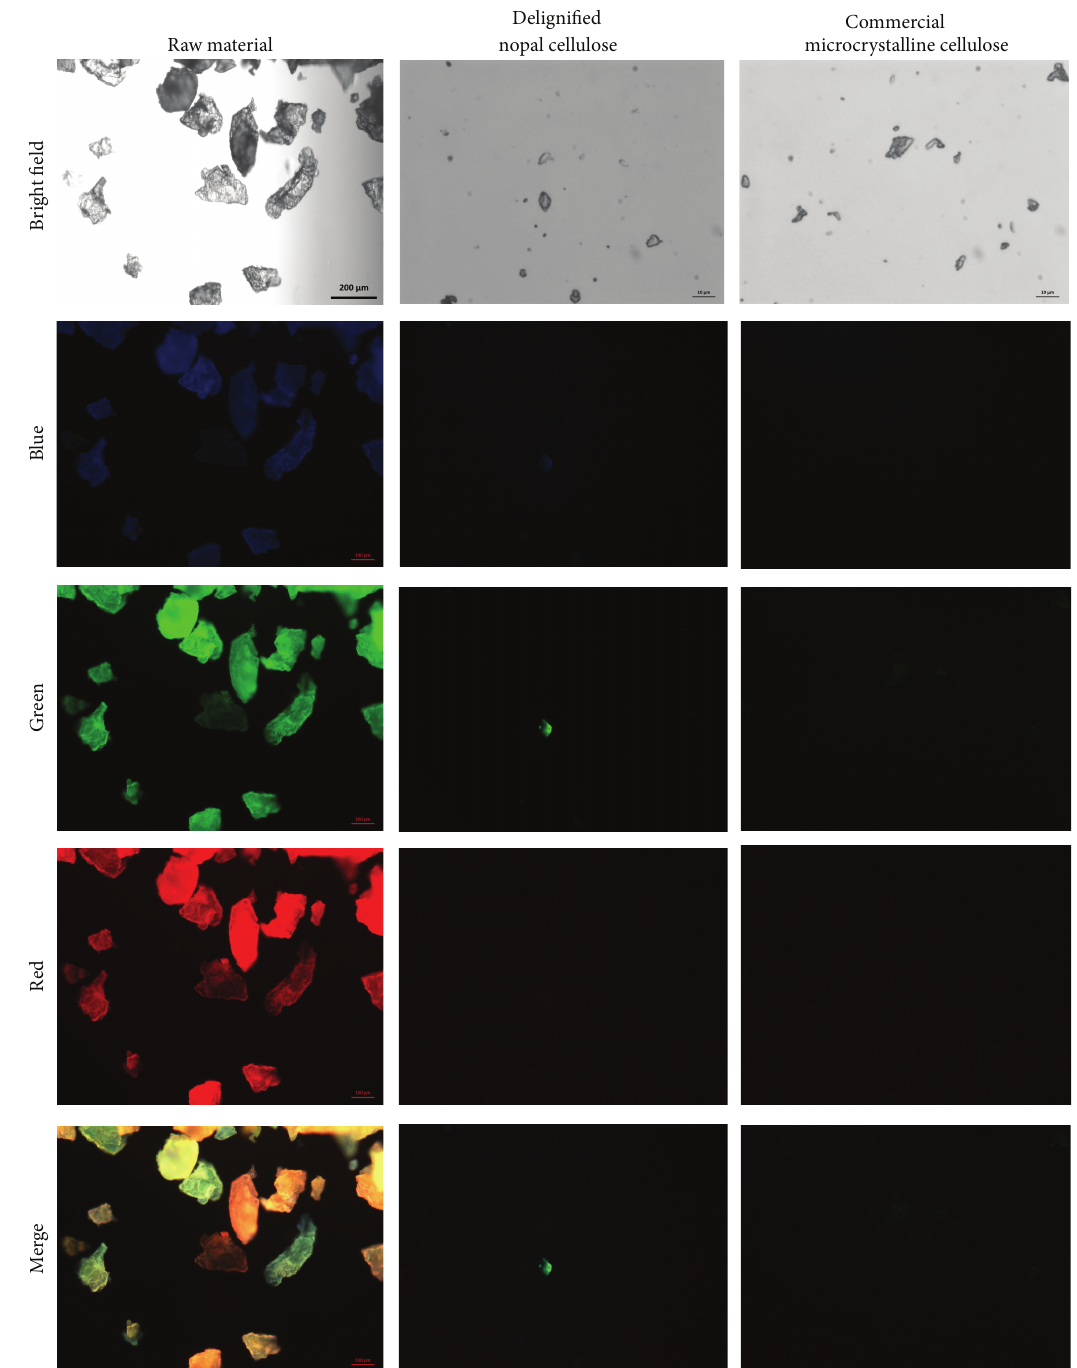
Figure 2: Photophysical properties by epifluorescence microscopy of the nopal raw material, delignified cellulose, and commercial micro- crystalline